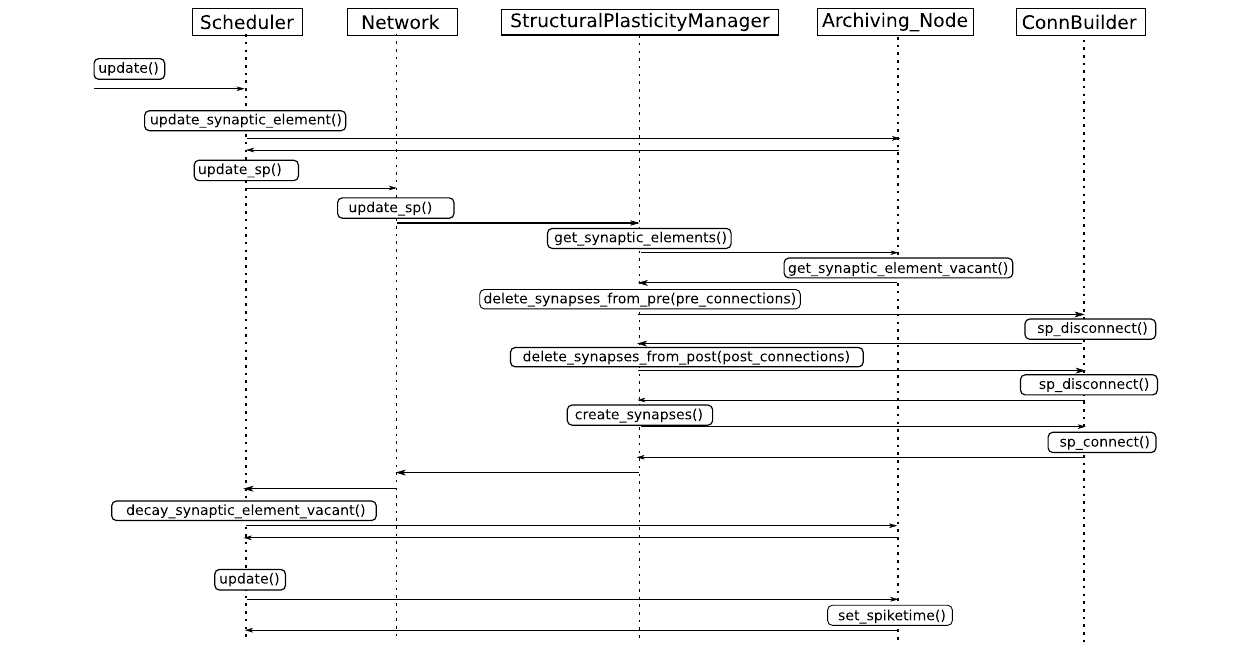
Frontiers in Neuroanatomy |